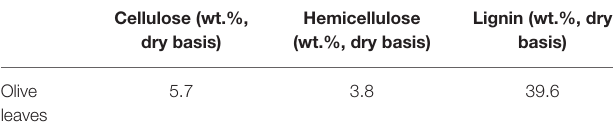
Olive leaves’ composition can be broadly divided into lignocellulosic and what the literature refers to as olive leaf extract. The lignocellulosic compounds of olive leaves consist of different concentrations of cellulose, hemicellulose and lignin.